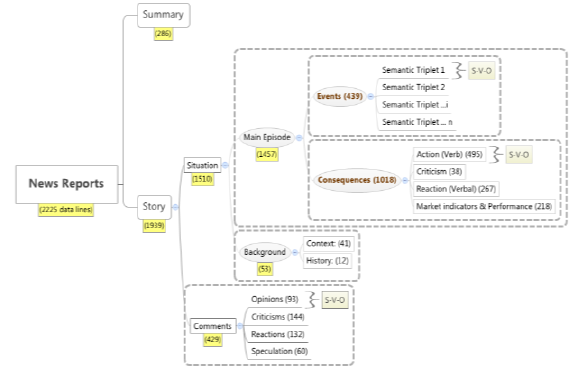
Figure 1: Deep Structural Schema for news reports Source: adapted from Van Dijk (1988: